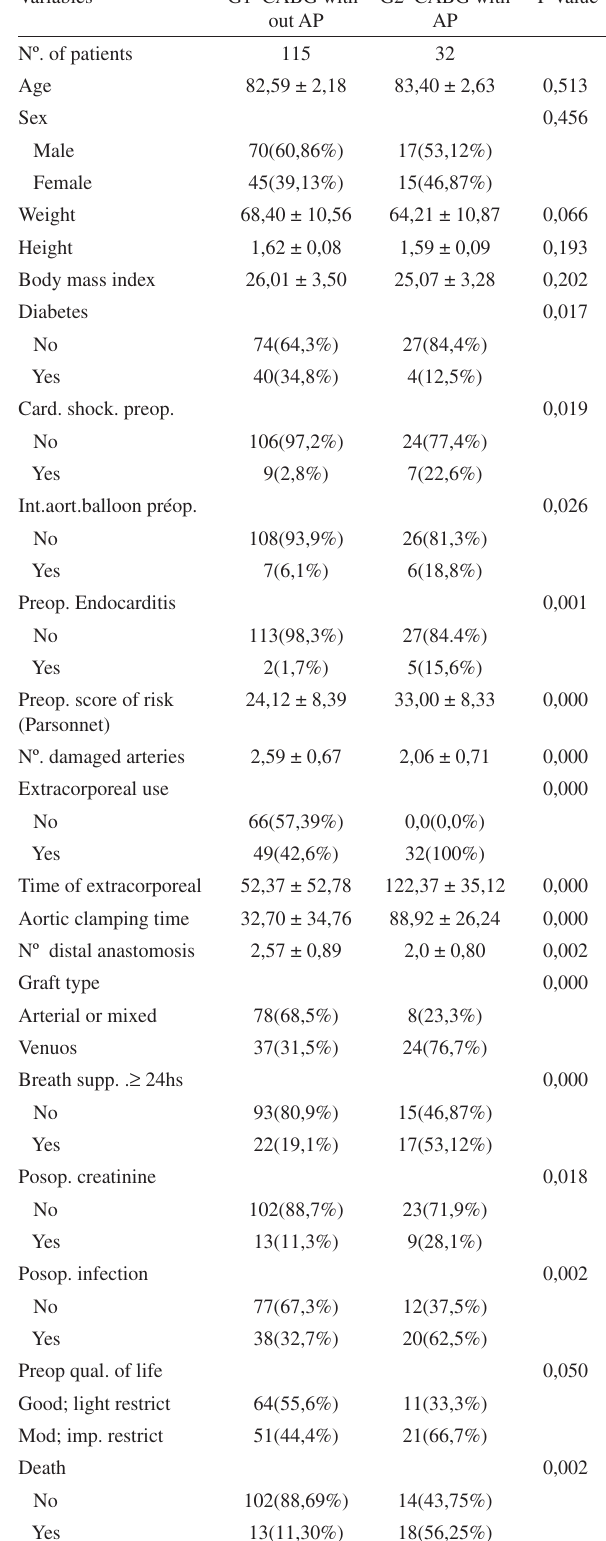
Table 1 - Characterization of the